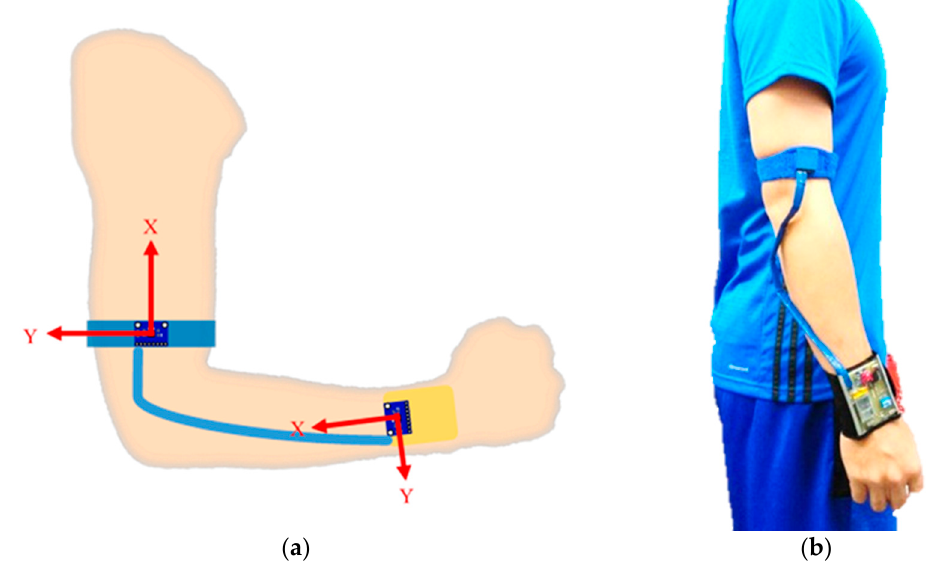
Figure 3. ( a ) Schematic diagram of the embedded device worn on the right arm; ( b ) and the actual diagram of the embedded device worn on the user’s arm.